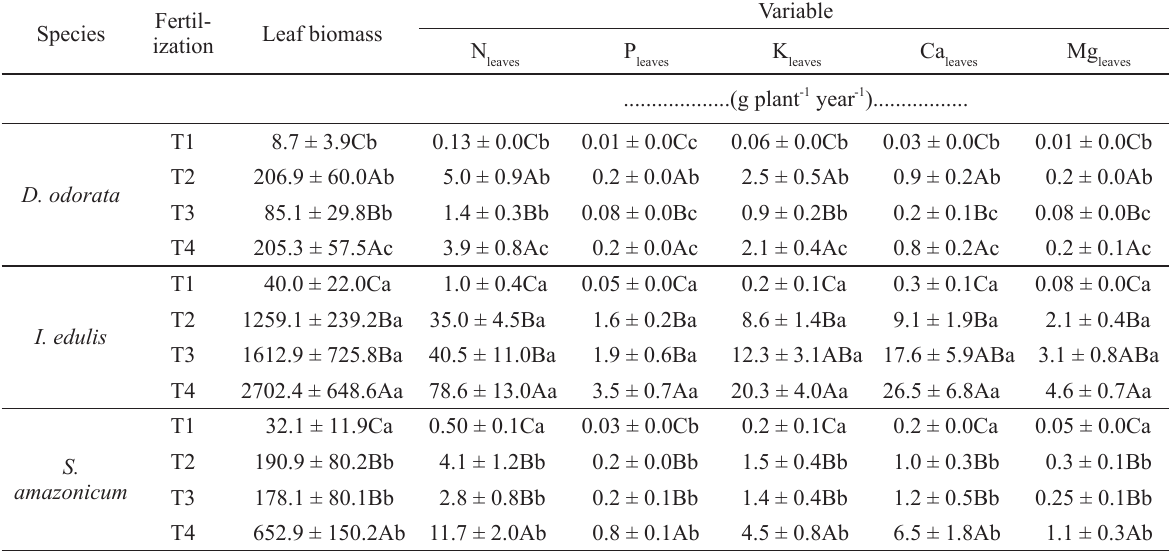
Macronutrient assimilation rates in the leaf tissues of the three tested species in a forest restoration plantation in an area degraded by the Balbina Hydroelectric Dam, AM - Brazil. T1 – no fertilization, T2 – chemical fertilization, T3 – organic fertilization, and T4 – organic and chemical